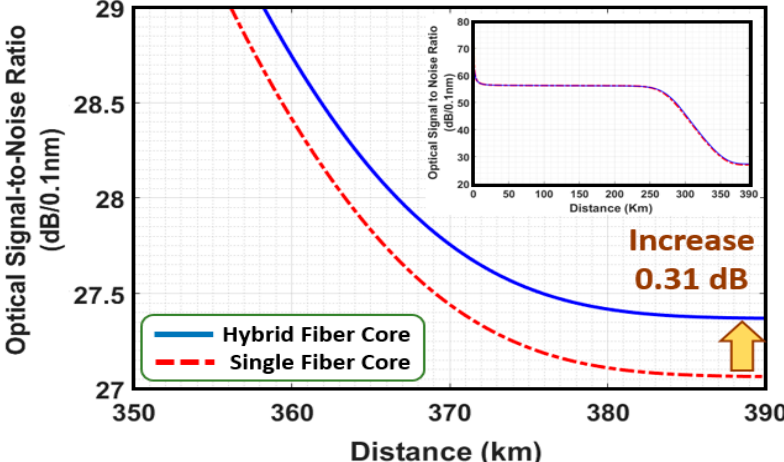
Figure 6. Optical signal-to-noise ratio (OSNR) of the three-segment hybrid fiber core structure compared to the conventional single fiber core structure. The hybrid fiber core structure has a higher delivered OSNR at the received point, which enhances the signal performance. The inset figure shows the profile along the entire propagation span.